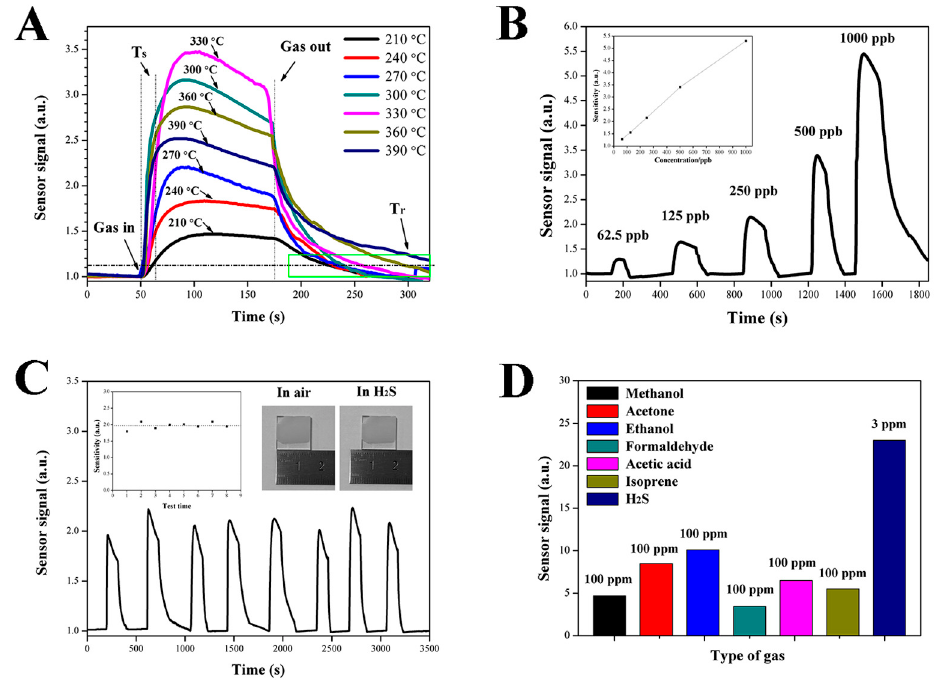
Figure 5. ( A ) Response of ZnO NCs sensors to 500 ppb H 2 S at a different temperature. ( B ) The response of ZnO NCs sensors to different concentrations of H 2 S at 330 ◦ C. ( C ) Stability tests of ZnO NCs sensors to 200 ppb H 2 S at 330 ◦ C. ( D ) Selectivity nature of ZnO NCs sensors to the different target gas.